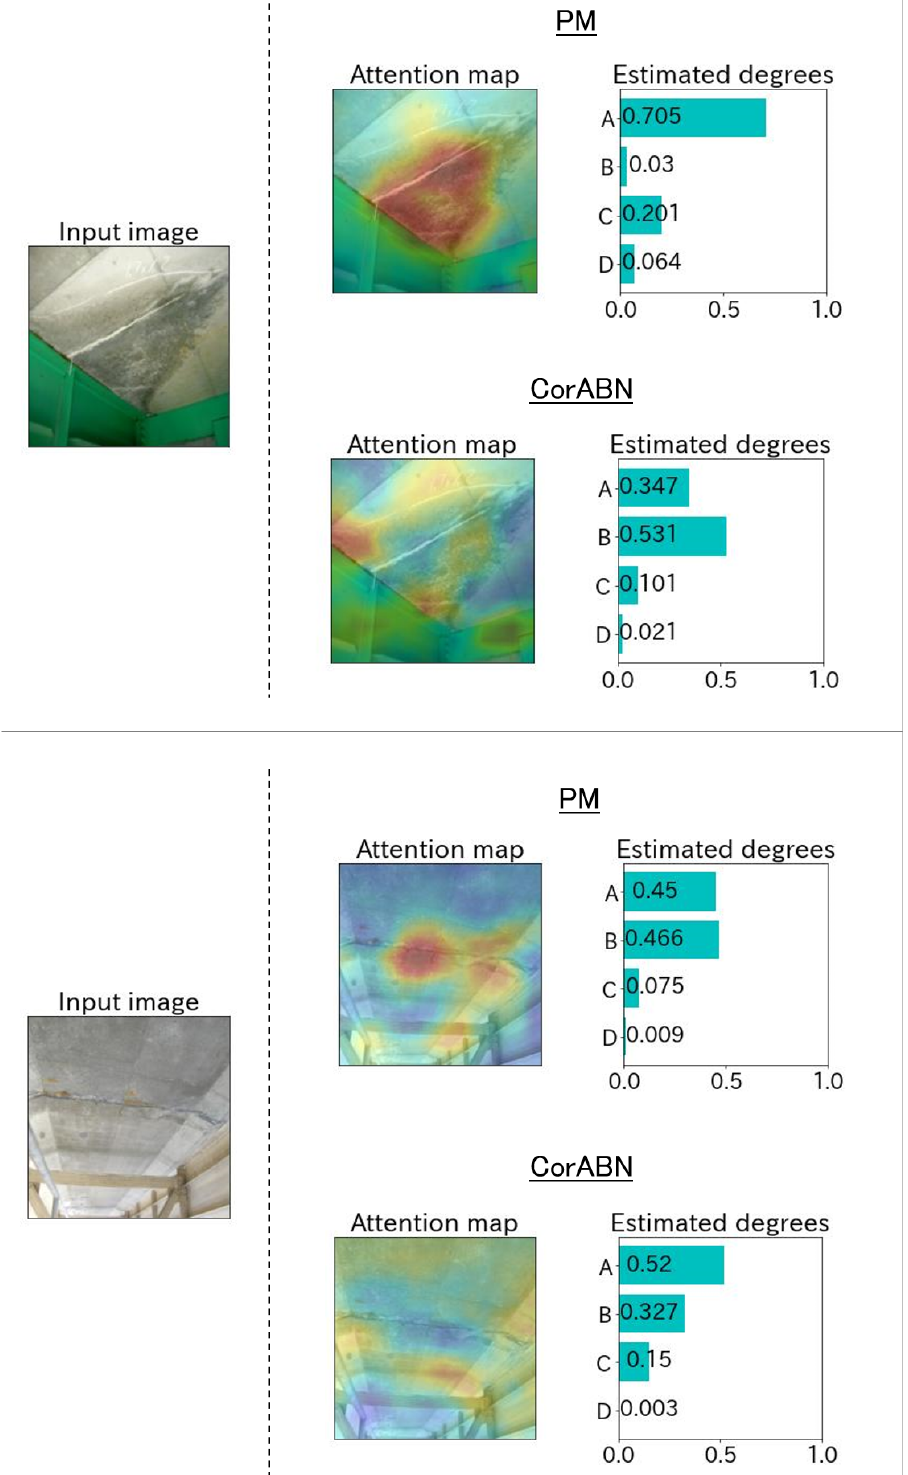
Figure 8. Estimated examples at the degradation degree A for the distress type of